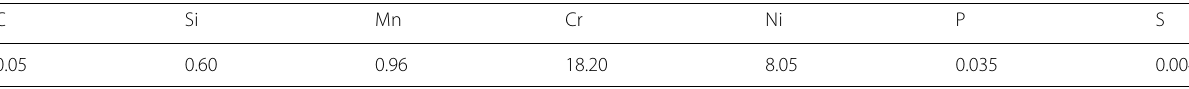
Table 1 Chemical compositions of the studied ASS 304 (wt%)